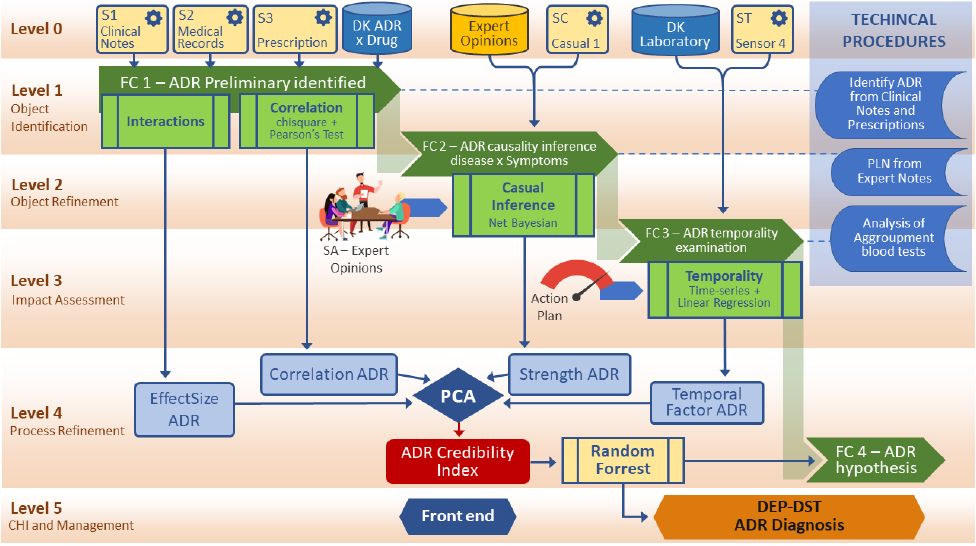
Figure 6. DEP-DST Credibal BPA applied to the ADR